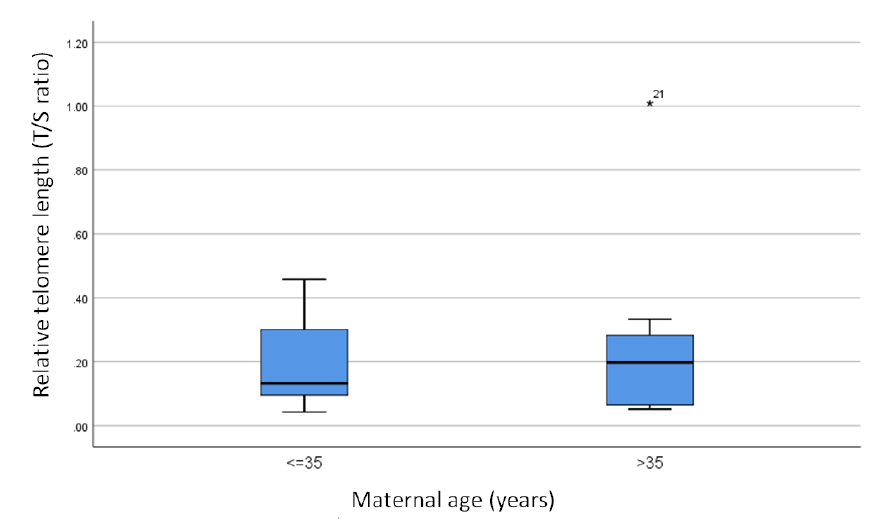
Figure 3. Average relative telomere length in all blastomeres from younger women ( n = 11) compared to those from women of advanced maternal age ( n = 11). Relative telomere length is shorter in blastomeres derived from couples in which women were younger however this difference was not statistically significant ( p = 1.0). The line on the lower end of the whisker represents the minimum T/S ratio, the bottom of the box represents the first quartile, the line through the middle region of the box represents the median T/S ratio, the top of the box represents the third quartile and the line at the top of the whisker represents the maximum T/S ratio. Circles represent outliers between 1.5 and 3 box lengths from the upper region of the box. Asterisks represent extreme outliers that are more than 3 times the interquartile range from the 3rd quartile.